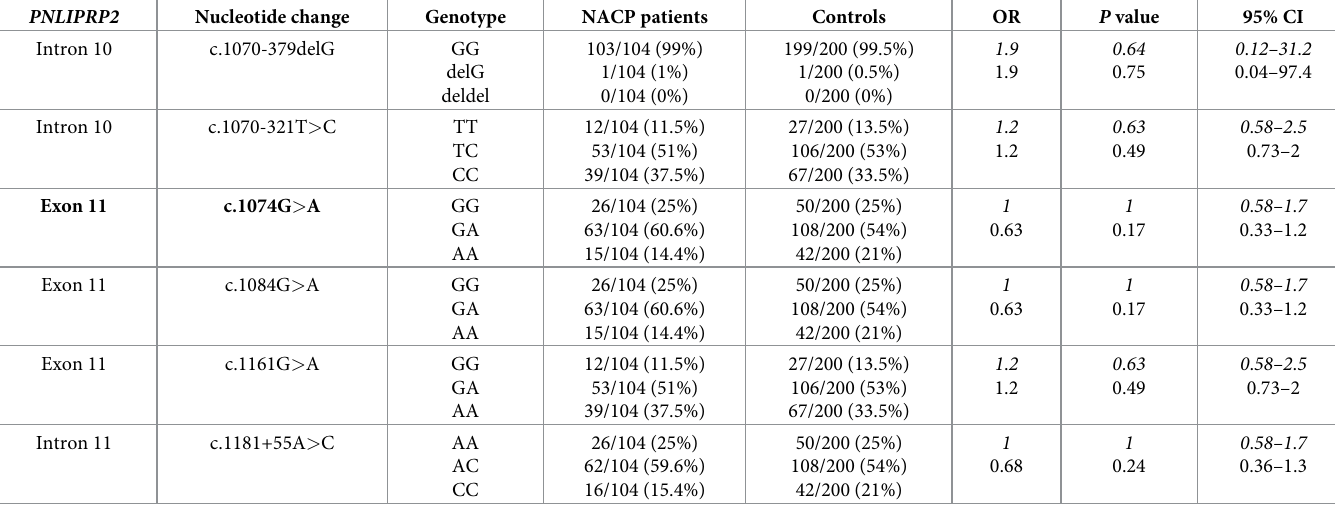
Table 8. Genotype distribution of PNLIPRP2 variants in patients with non-alcoholic chronic pancreatitis (NACP) and in controls.